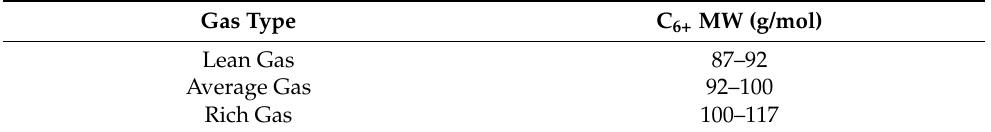
Table 8. Classification of the 46 gas samples evaluated by this work to develop the PINA Attalla method in accordance with their C 6+ MW.